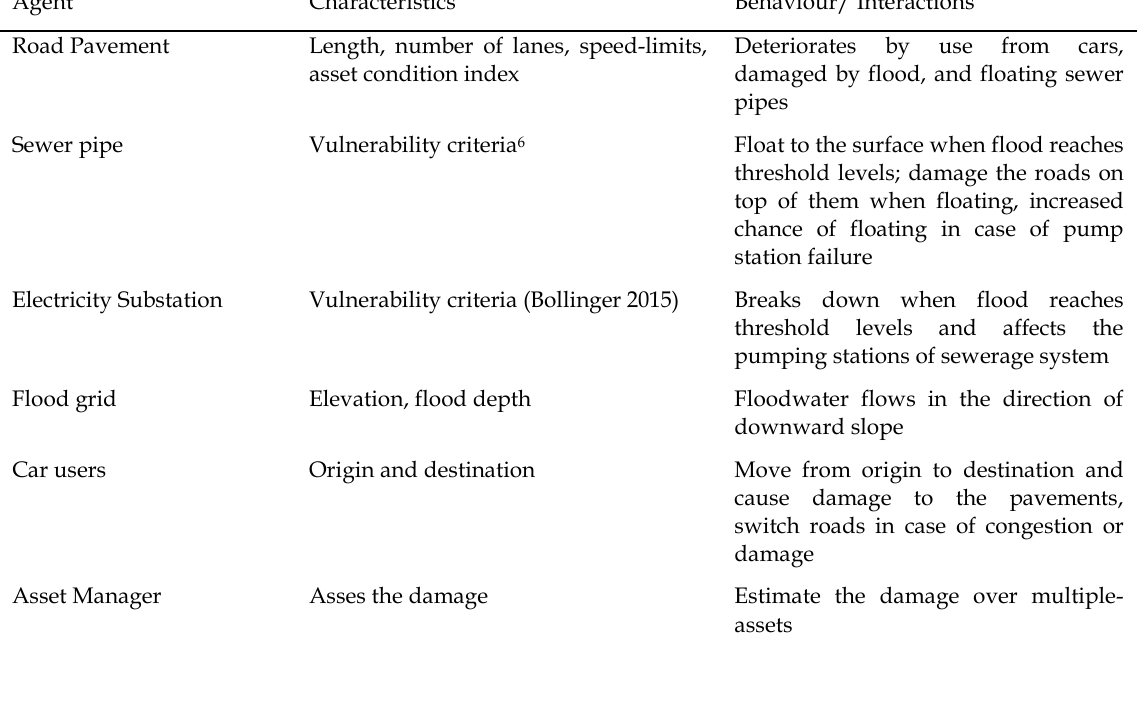
Table 1. Description of agents, their characteristics and defined